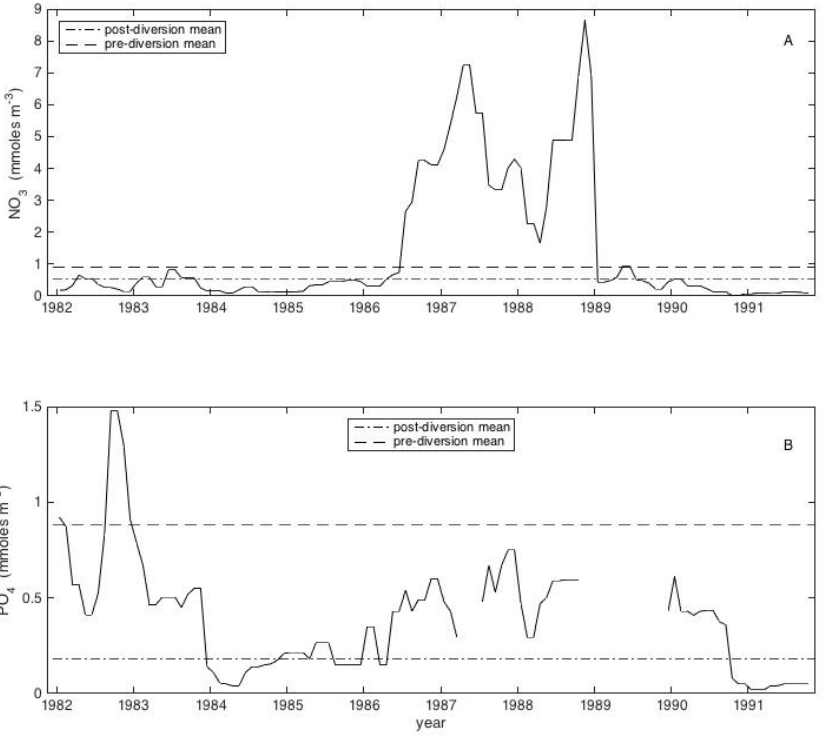
Figure 5. ( A ) The six-month running means of nitrate concentrations in the SE sector of Kaneohe Bay and ( B ) the three-month running means of phosphate concentrations in the SE sector of Kaneohe Bay. Tick marks as in Figure 2.